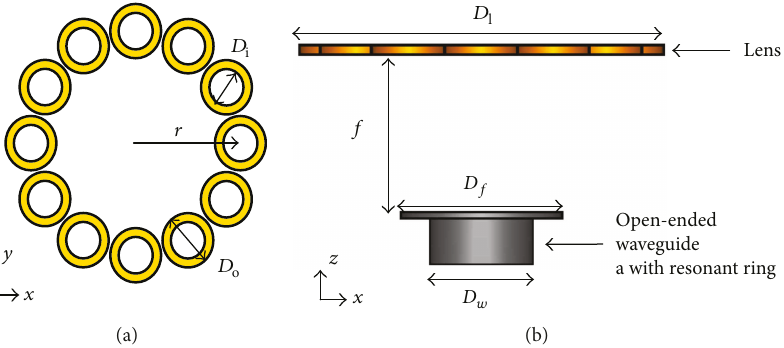
Figure 1: Geometry of the proposed lens antenna: (a) top view and (b) lateral view.